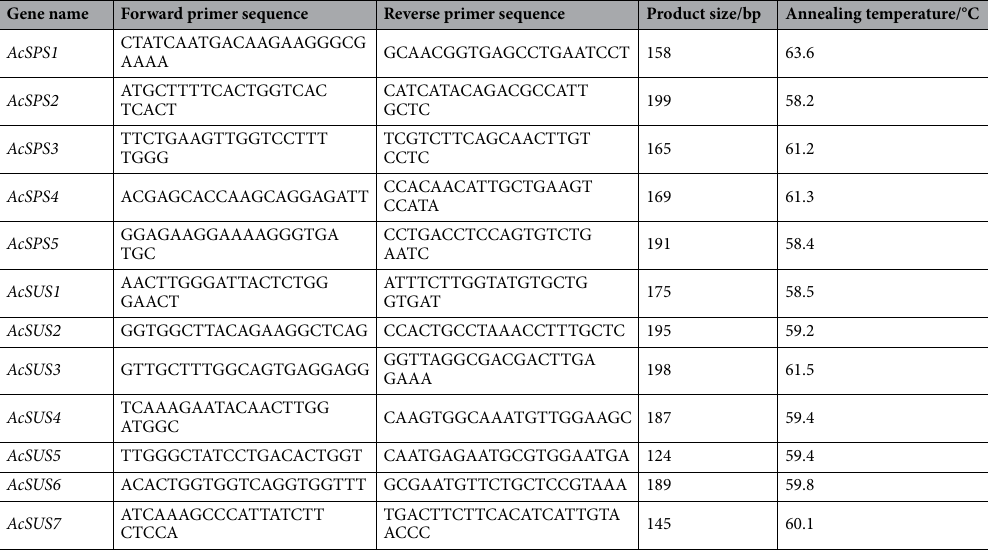
Table 1. Designed primers of quantitative real-time